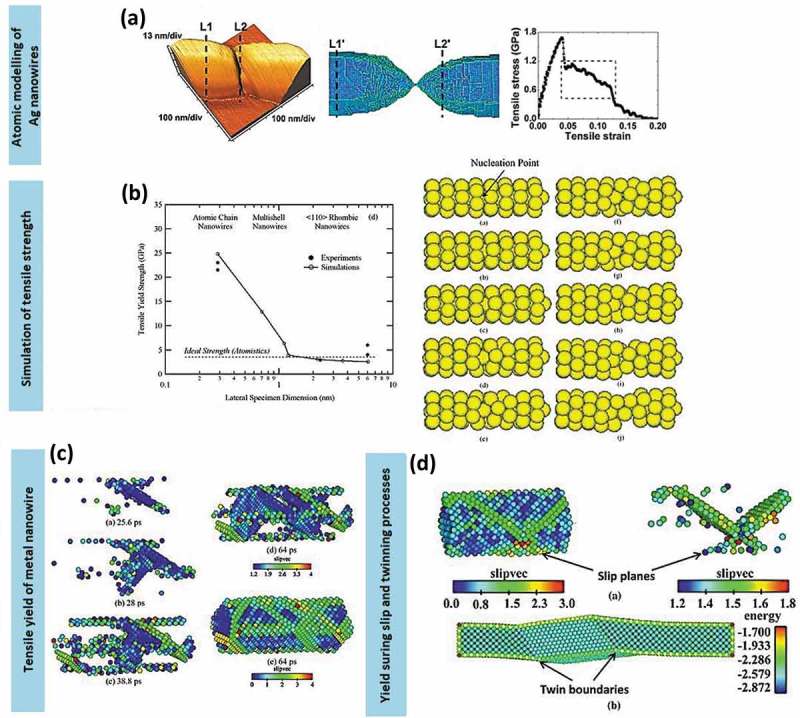
(a) The atomic modelling of Ag nanowire with a diameter of 15 nm under tensile stress before the deformation corresponds to the AFM image after the nanoindentation test. The tensile stress-strain plot shows prediction results from atomistic simulations [266]. (b) The multishell nanowire with the yield strength takes place at the local tensile fracture in the atomic junction [30]. (c) The tensile yield of the metal nanowires with the coloured atoms is defined according to the slip vector, and only the atoms that have slipped are shown in a to d, while all of the present atoms are shown in e [268]. (d) Slip during the yielding and twinning during deformation of the Au nanowire. The left snapshot shows all atoms, while the right snapshot presents only atoms on the slip planes. The atoms are coloured based on the magnitude of the potential energy [267]. (Adapted from [266] with permission copyright (2008) by the American Physical Society, adapted with permission from [30] copyright (2004) American Chemical Society, reproduced from [268] with permission from Elsevier, reproduced from [267] with permission from Springer).